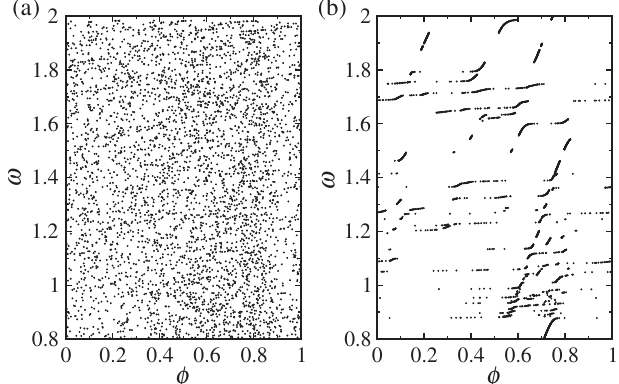
FIG. 11. Snapshots of the probability density Q ð ϕ ; ω ; t Þ for g ¼ 0 . 5 [panel (a)] and g ¼ 1 . 3 [panel (b)] and N ¼ 4000